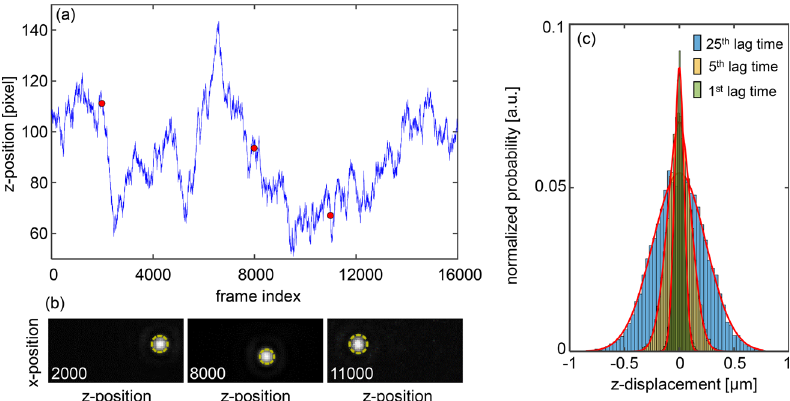
Figure 3: Longitudinal trajectory of the single gold nanosphere considered here. (a)Trajectoryalong z -direction.Thethreered dots mark the examples of frames which are shown in (b). (b) Selected frames from the trackingvideo,with thedeterminedposition of the particle marked by the yellow dashed circles. The number indicates the frame. (c) Histogram of the probability of the nanosphere displacement along the z -direction at different time intervals. The lines refer to the corresponding normal distribution fi tting curves (red